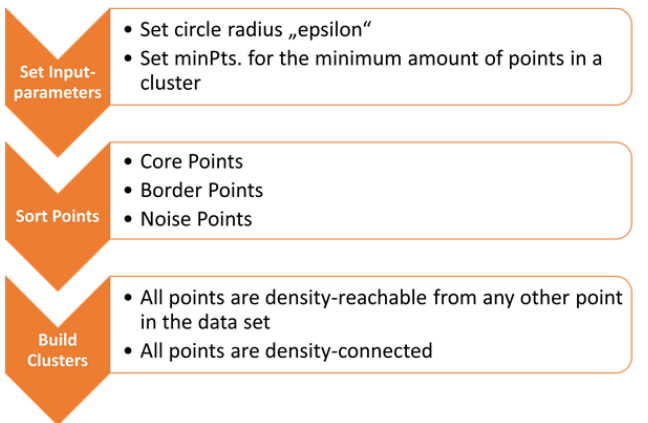
Figure 3. Flowchart of the density-based spatial clustering of applications with noise